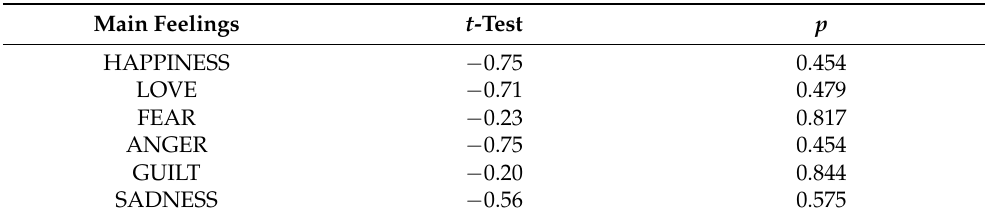
Table 8. Differences between the values of the mean for the main emotions in the group of inmates who were (N = 109) and were not infected with SARS-CoV-2 (N = 141).